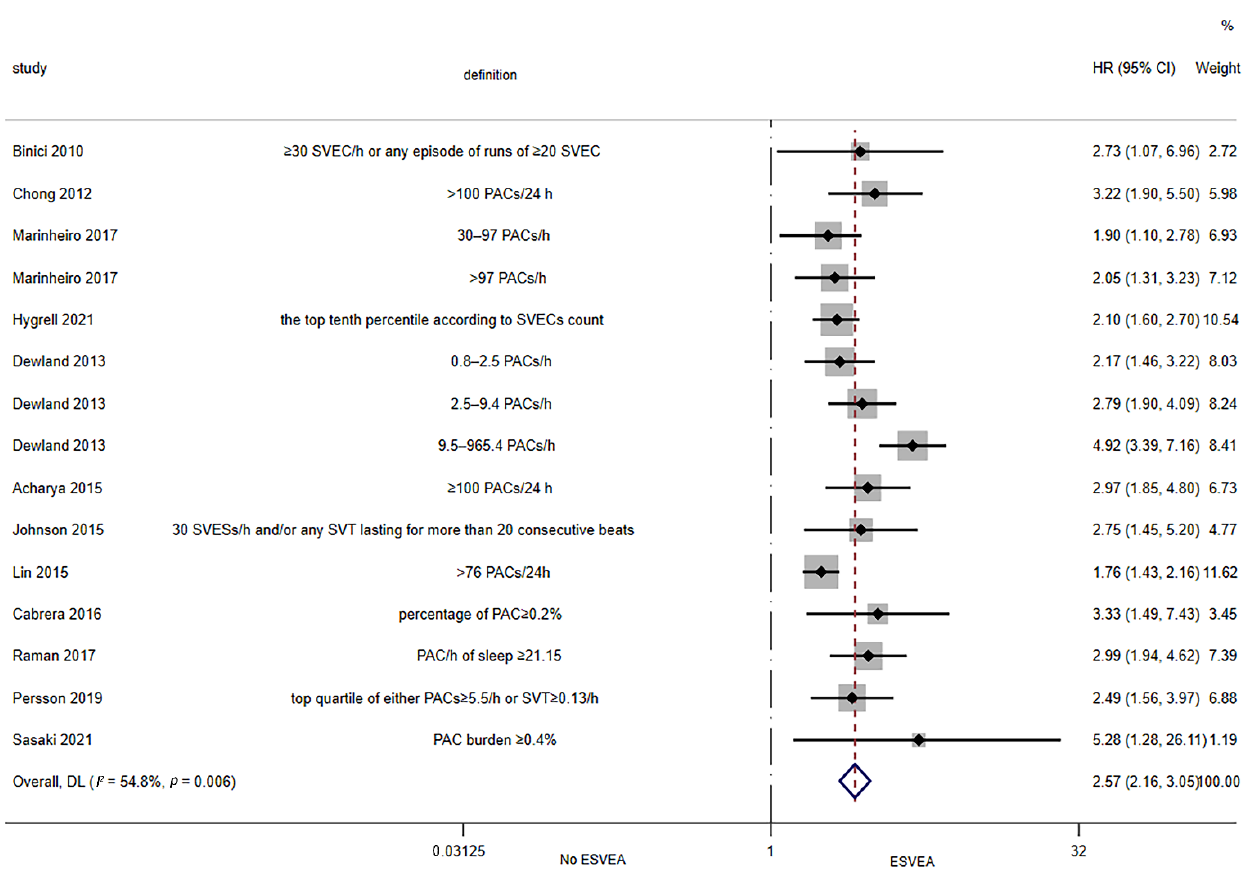
Figure 2. Forest plot of the association between ESVEA and AF in the general population. Abbrevi- viations: SVEC—supraventricular ectopic complexes; PACs—premature atrial complexes; SVESs— ations: SVEC — supraventricular ectopic complexes; PACs — premature atrial complexes; SVESs — supraventricular extrasystoles; SVT—supraventricular tachycardias; ESVEA—excessive supraventricular extrasystoles; SVT — supraventricular tachycardias; ESVEA — excessive supra-